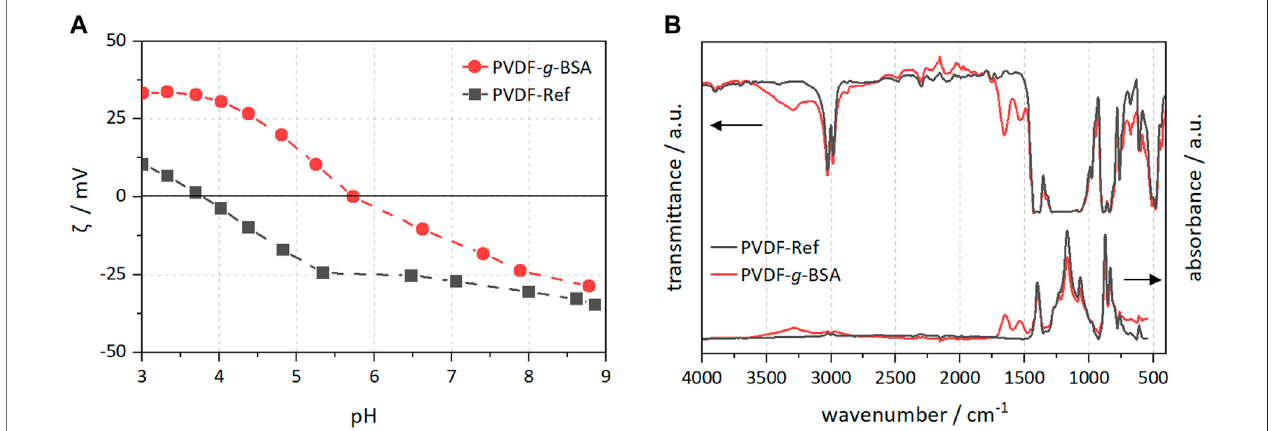
FIGURE 6 | PVDF surface characterization of modi fi ed and reference samples. (A) Zeta potential measurements; and (B) FTIR spectra in transmission and ATR mode.